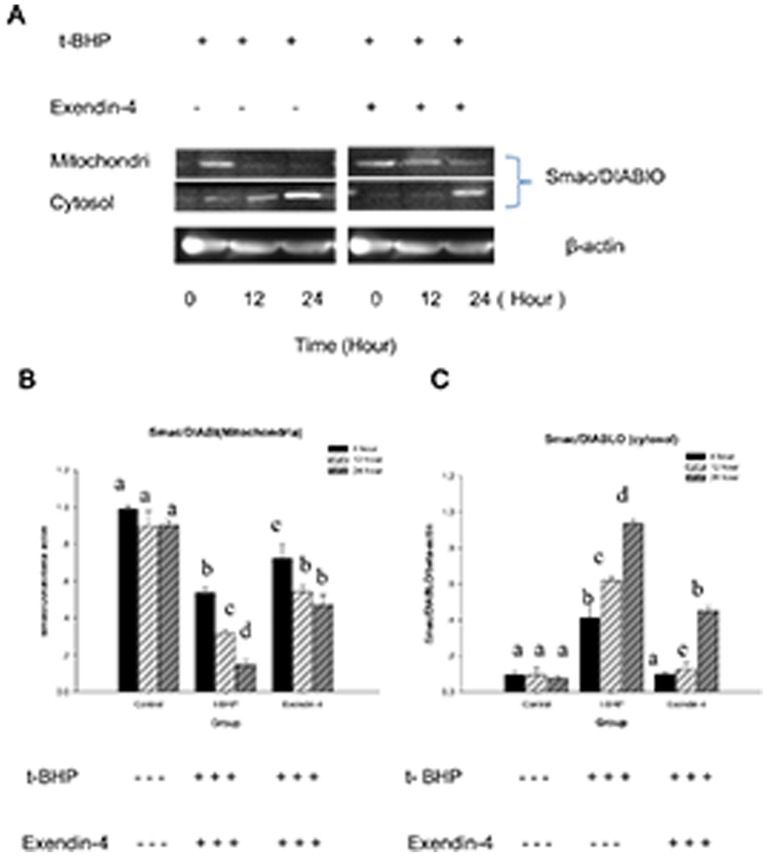
Exendin-4 attenuates the release of Smac/DLAMO from the Min6 cell mitochondria.Figure A shows the effect of Exendin-4 on Smac/DLAMO in Min6 cells. The cells were treated with or without Exendin-4 and then with t-BHP for different intervention times. The cells were then collected, and cytoplasmic mitochondrial fractions were prepared with a mitochondrial/cytosol fraction kit. The samples from each fraction were analyzed using Western blot for Smac/DLAMO. Figure B presents the mitochondria. Figure C includes the group gray comparison (cytoplasm). The data are expressed as the means±S.D. (n = 6). a, b, c, d and e indicate the blank comparison and the t-BHP (200 µM for 24 hours) and Exendin-4 (100 µM for 48 hours) group comparisons (p<0.05).